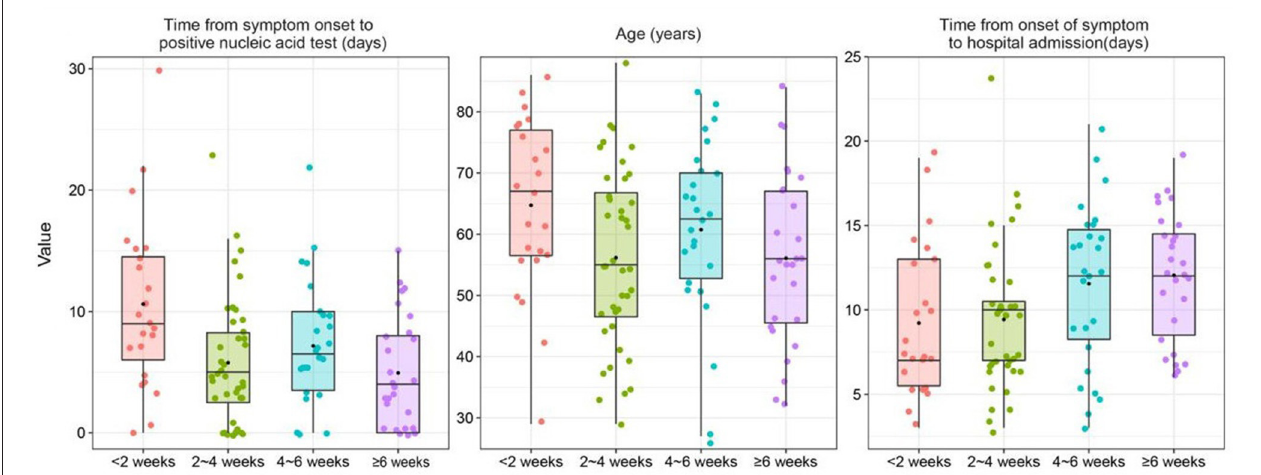
FIGURE 2 | Box plot of variables grouped by the conversion time from positive to negative nucleic acid test was combined with the results of the univariate cox regression analysis and expertise.